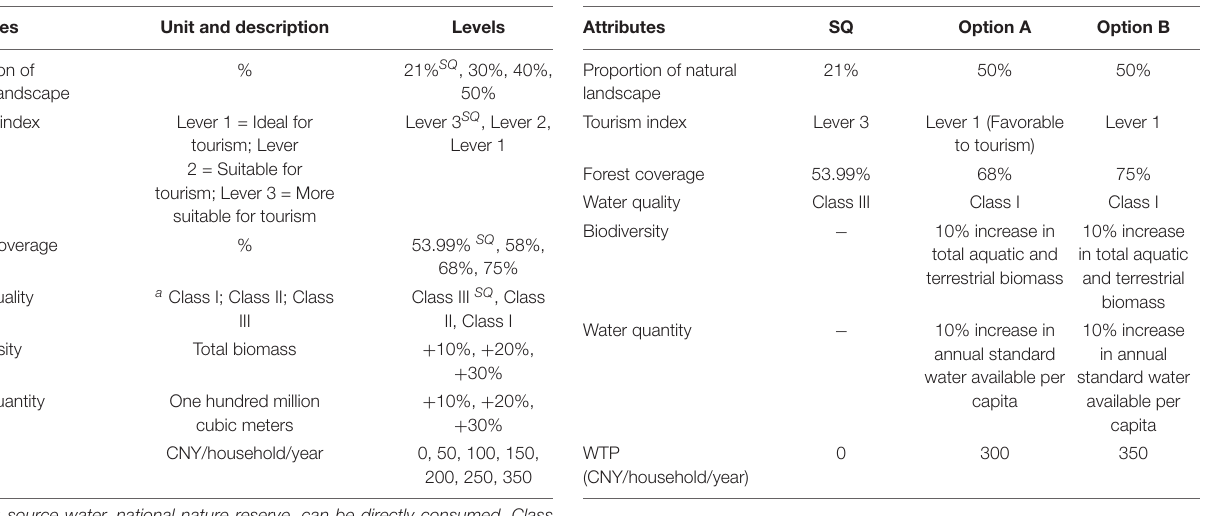
TABLE 1 | Attributes and levels in CE. TABLE 2 | Example of choice set used in